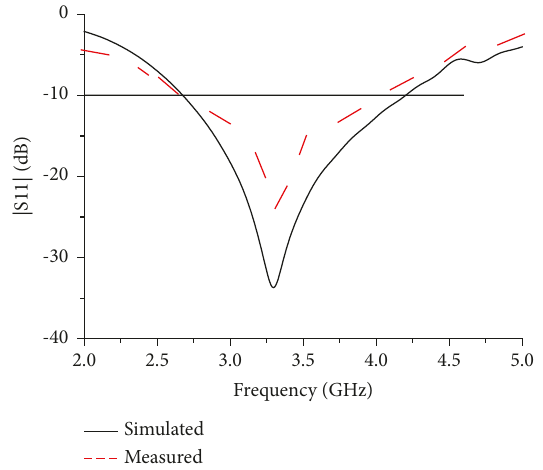
Figure 2: S 11 curve of the designed MPA.